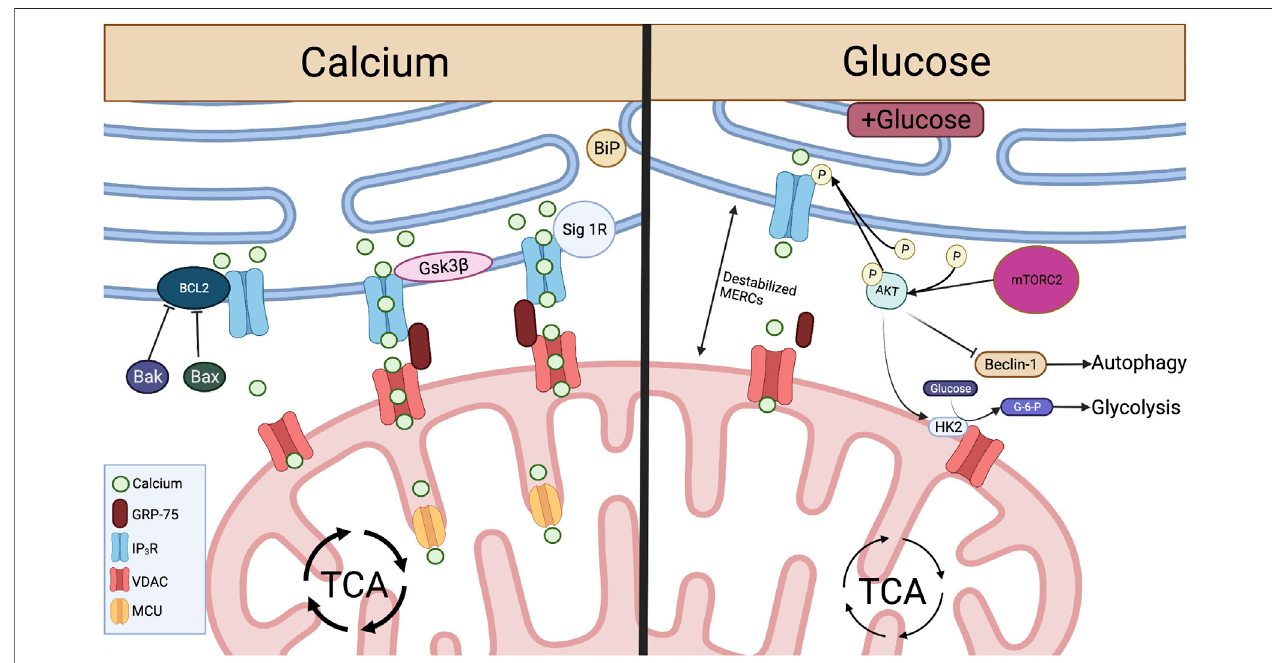
FIGURE2| Crucialmetabolite fl owandnutrientsensingoccursatMERCsandismediatedbyproteinsactingontheIP 3 R-GRP75-VDACcomplex.Left:AtMERCs, Ca 2+ is transferred from the ER lumen, through the IP 3 R-GRP75-VDAC complex, into the mitochondrial intermembrane space and through MCU to the mitochondrial matrix.ThisCa 2+ fl uxispromotedbySig-1RdissociationfromBiPandtheproteinGsk3 β interactionwithIP 3 R.Ca 2+ fl uxandIP 3 R-GRP75-VDACassociationisinhibited by Bcl2, and this interaction is inhibited by pro-apoptotic proteins Bax and Bak. Right: When glucose is available, mTORC2 phosphorylation of AKT leads to reduced ER Ca 2+ release and disruption of MERCs through inhibition of IP 3 R. pAKT also inhibits Beclin-1, a promoter of autophagy at MERCs. pAKT activation of HK2 leads to conversion of glucose to G-6-P, spurring glycolysis. Created with BioRender.com.